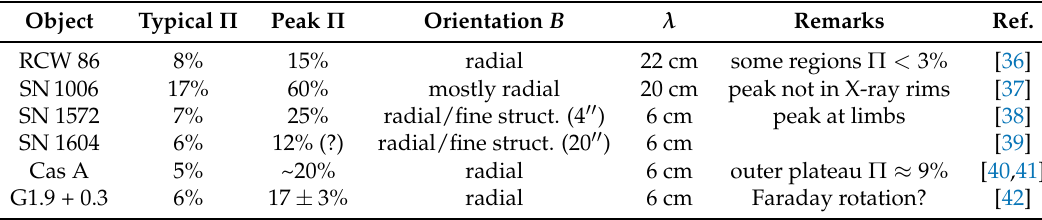
Table 1. Radio polarisation measurements of young SNRs.